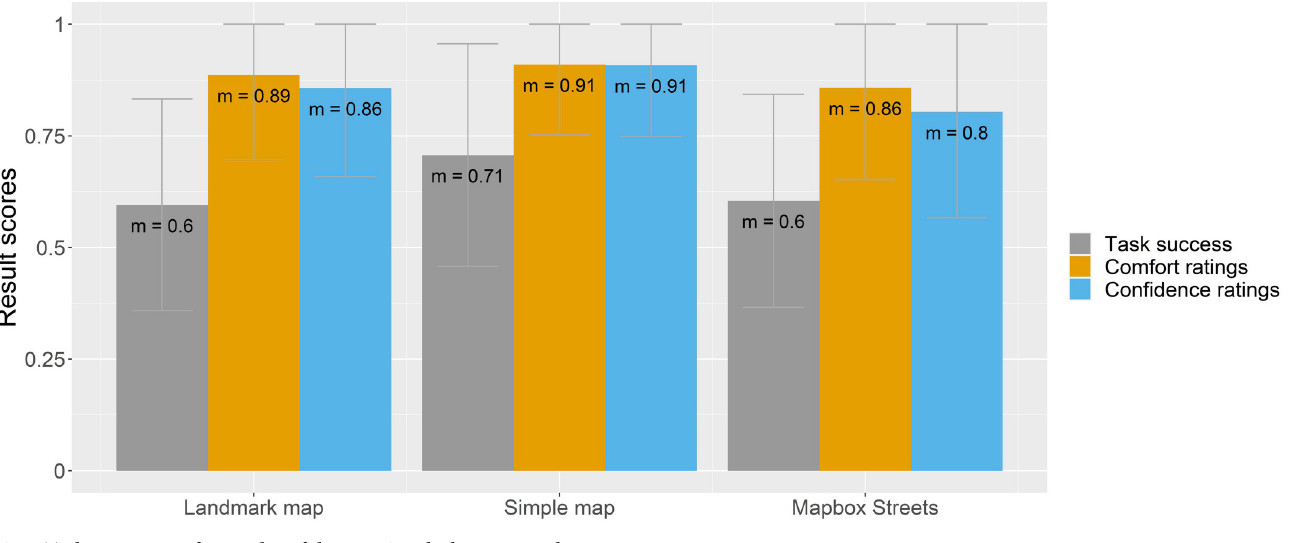
Fig 7. Task success, comfort, and confidence ratings by base map style.